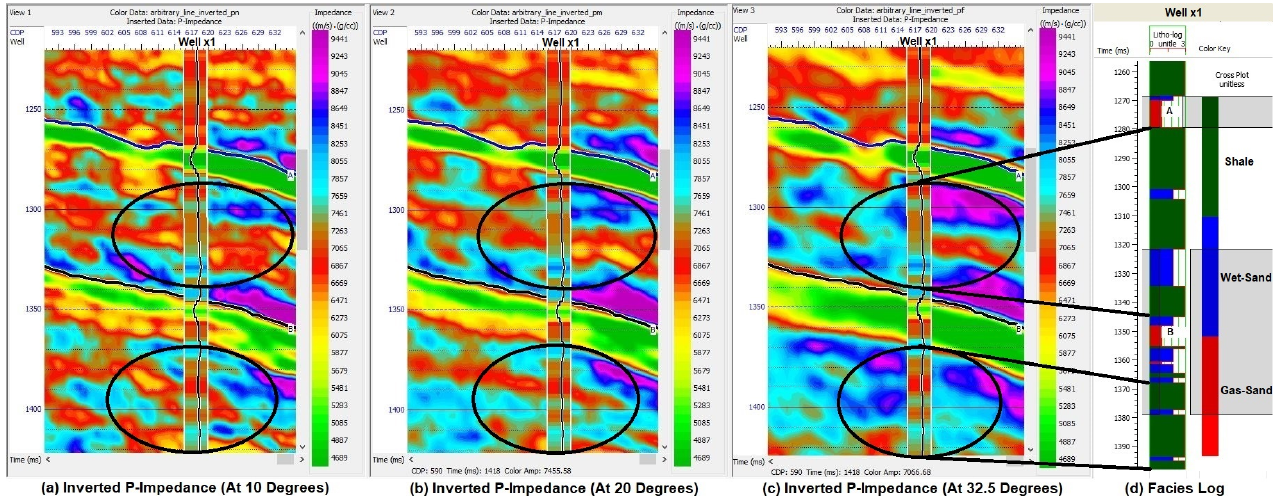
Figure 8. The partially inverted Z P sections at the near, mid, and far incident angles (from ( a – c ), respectively) against the facies log at well × 1 ( d